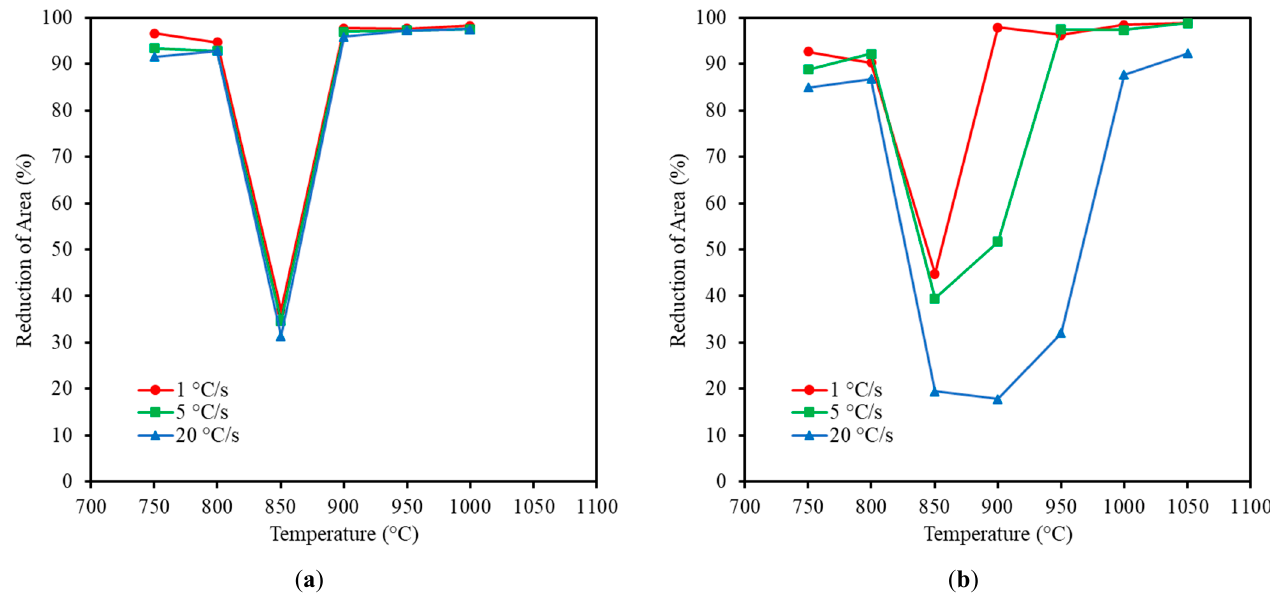
Figure 9. Hot ductility curves at various cooling rates for: ( a ) B-free steel and ( b ) B-containing steel [45]. Adapted from [31], with permission from Springer, 2023 steel [45]. Adapted from [31], with permission from Springer,